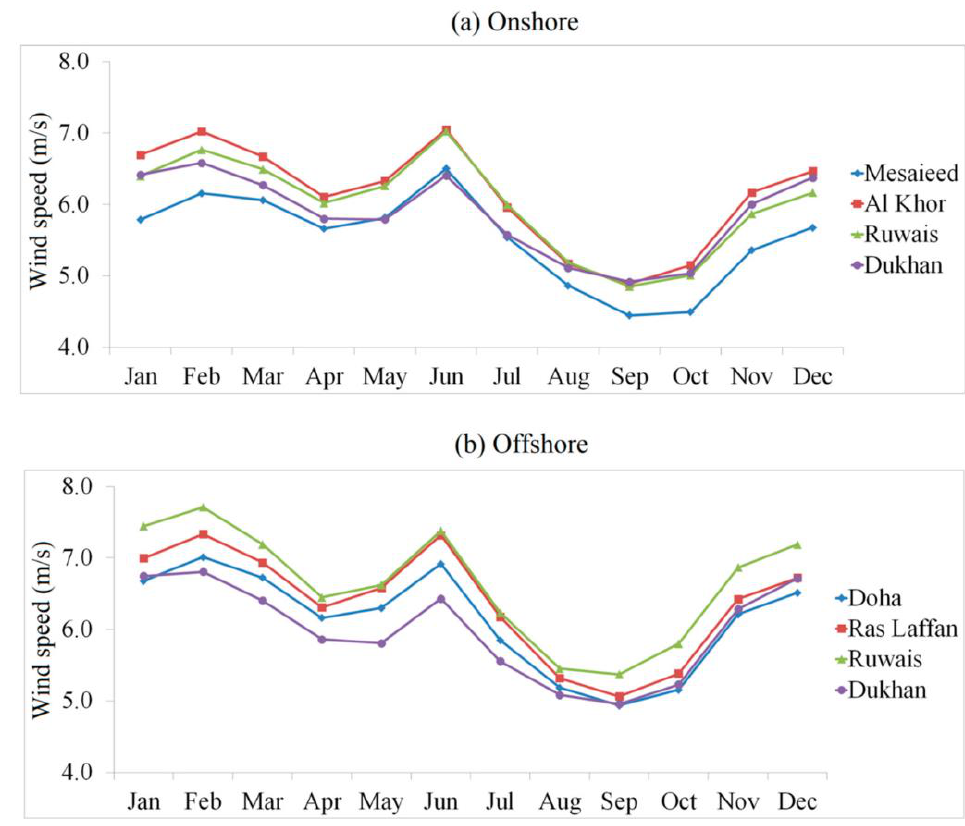
Figure 6. Monthly mean wind speeds at ( a ) onshore and ( b ) offshore locations of Qatar at a height of 90 m from 1979 to 2018 [11].